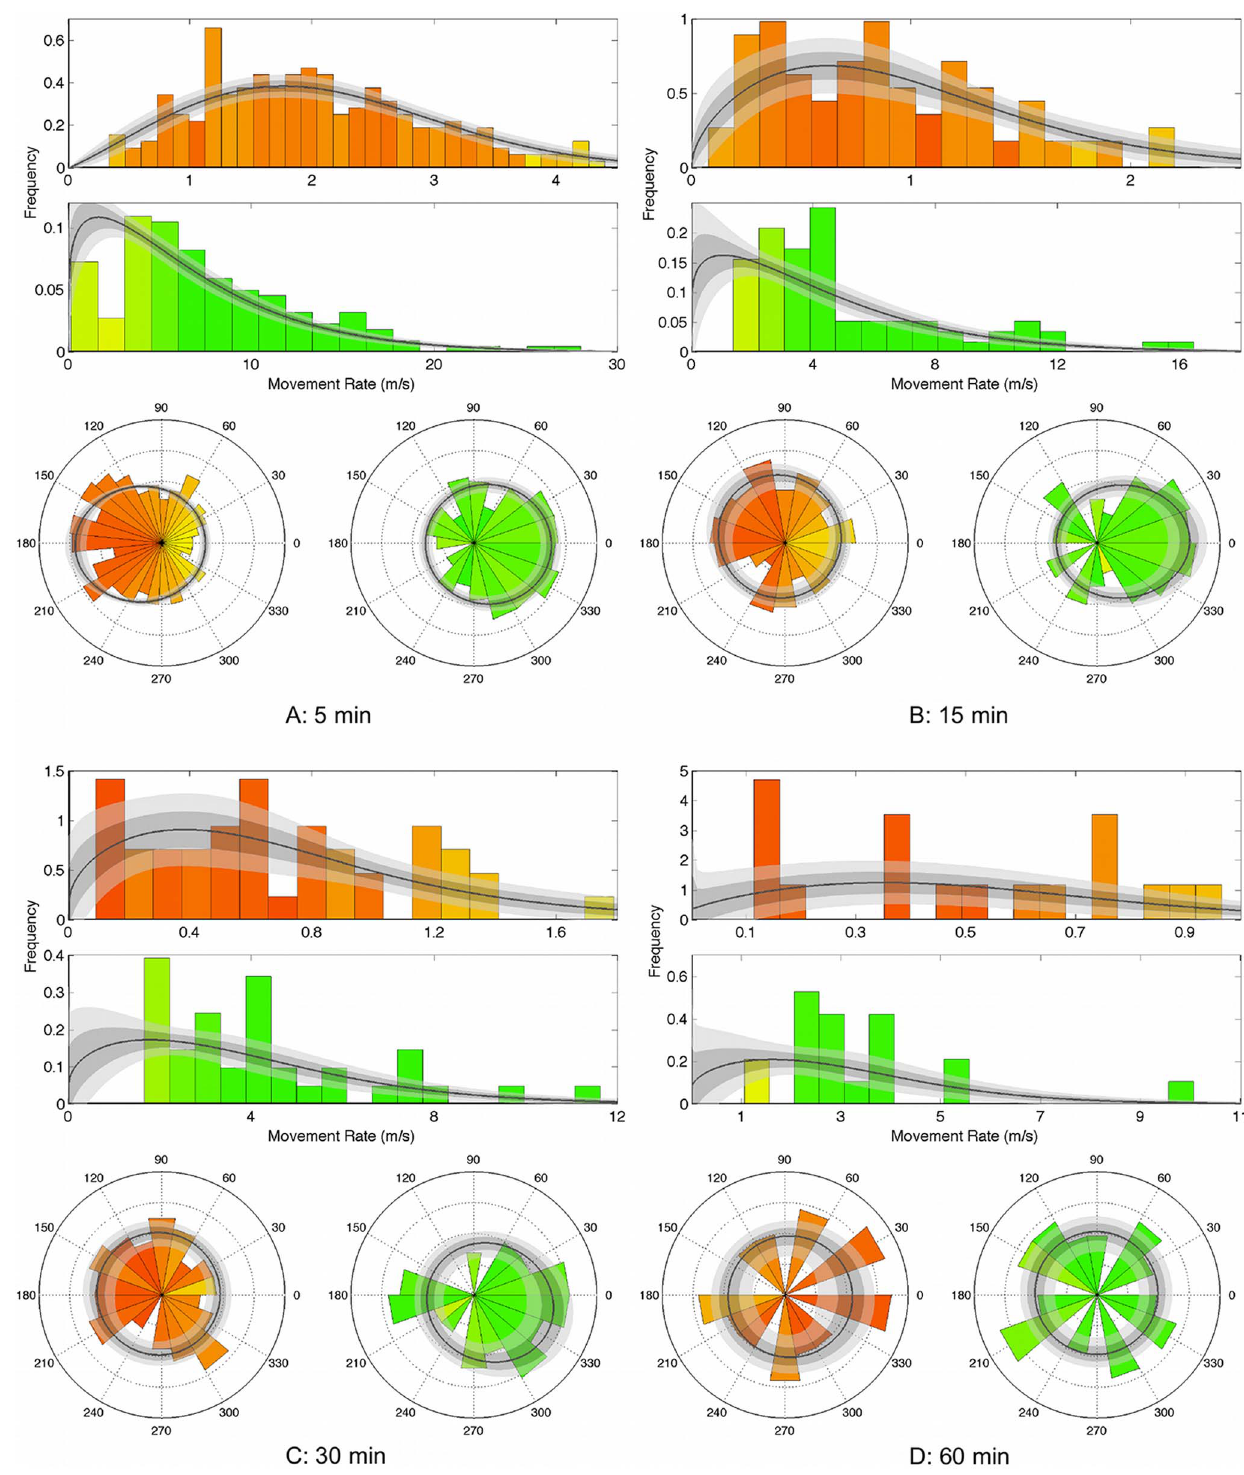
Figure 1. Movement-rate and turning-angle distributions of one set of trajectories (possum # 1882). Each sub-figure shows, for each state in the two-state model, movement-rate (top, in m/s) and turning-angle (bottom, in degrees) distributions, at subsampling frequencies of (a) 5 min, (b) 15 min, (c) 30 min and (d) 60 min. Lines and colors are as in Fig. 2.